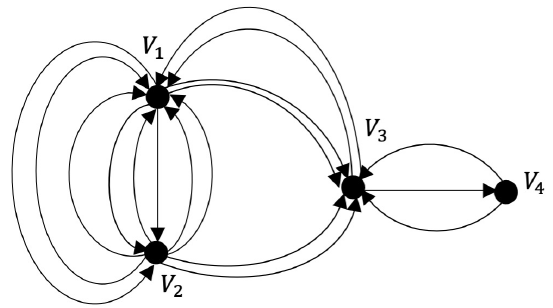
Figure 8. A multidigraph autocatalytic set G ( V , A ) .